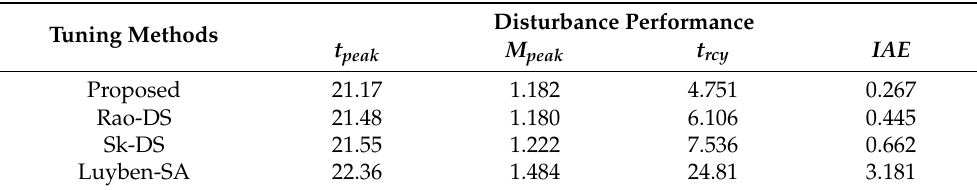
Figure 13. Regulatory responses to disturbance in IFOPTD under Gaussian noise N(0, 0.01 2 ). Table 10. Quantitative comparison of responses to disturbance in IFOPTD under Gaussian noise N(0, 0.01 2